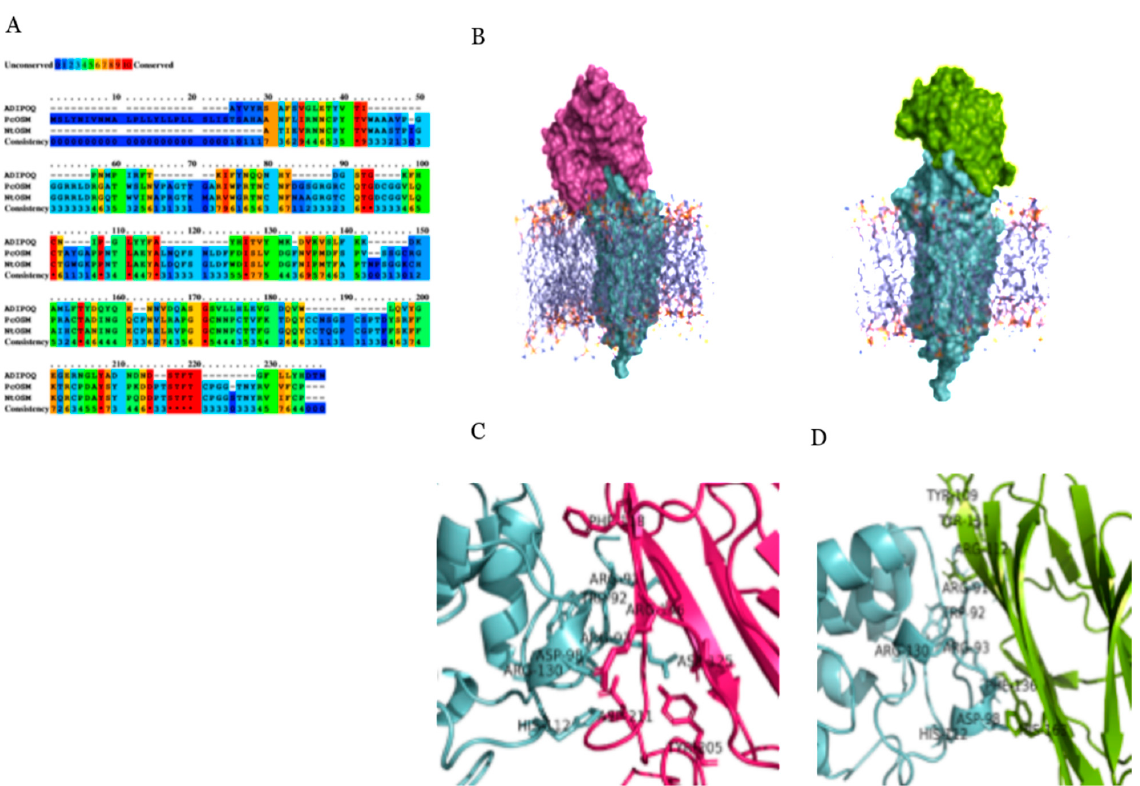
Figure 4. Molecular docking studies: ( A ) The multiple alignments of amino acid sequences of ADIPOQ, PcOSM, NtOSM compiled with PRALINE. Coloured blocks indicate conserved regions. ( B ) The helixes of ADIPOR1 are embedded in lipid bilayer membrane subjected to supervised docking with OSM (purple) and ADIPOQ (green) restricting their docking grid confined to intra-cellular loops of ADIPOR1. The lowest energy docking solutions were submitted to MD simulation for structural refinement. ( C ) Representative snapshot for free energy minima of ADIPOR1/OSM and ( D ) ADIPOR1/ADIPOQ complexes from simulations showing functional residues contributing highly towards effective binding at the interaction interface.